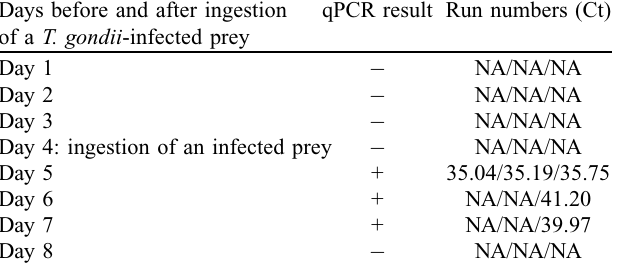
Table 1. Results of qPCR detection of Toxoplasma gondii DNA extracted from the feces of a housebound cat that had antibodies against this parasite and that had ingested a Toxoplasma gondii - infected prey on day 4. One stool analyzed per day. The run numbers are given for each of the three samples analyzed per stool. NA: no T. gondii DNA detected in the